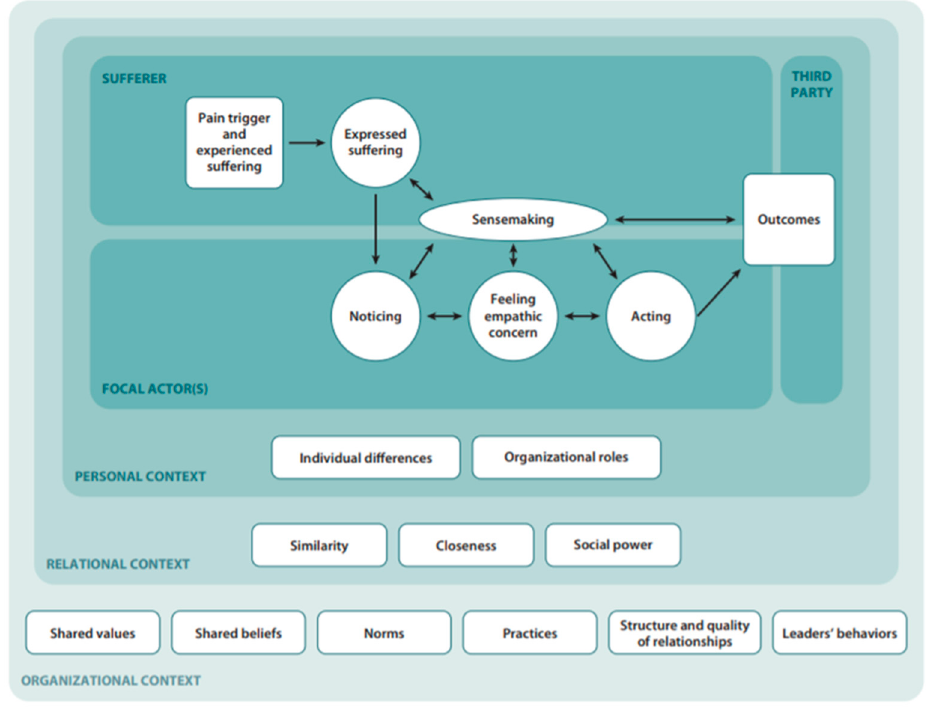
Figure 1 . Model of the Interpersonal Process of Compassion. Figure 1. Model of the Interpersonal Process of